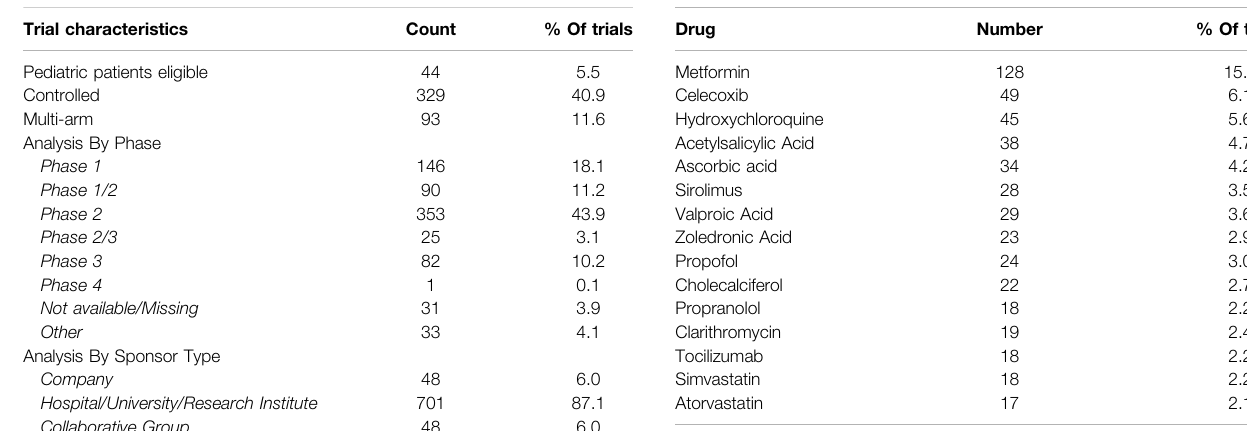
TABLE 3 | Most popular drugs by trial.